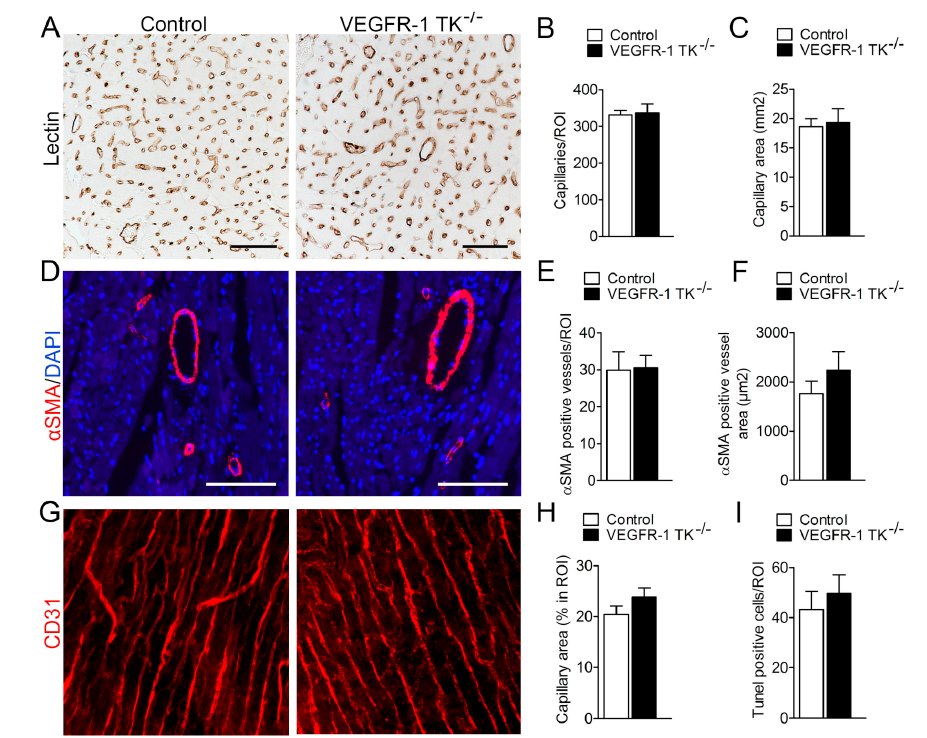
Figure 5. VEGFR-1 TK signaling does not affect angiogenesis. ( A ) Representative images of lectin staining of myocardial sections at day 14 of angII infusion (scale bar is 50 µ m). ( B ) Quantification of capillary density in LV (n = 7–9/group). ( C ) Quantification of capillary area (n = 7–9/group). ( D ) Representative images of staining for arteries ( α SMA; scale bar is 100 µ m). ( E ) Quantifica- tion of arterial vessel density (n = 8–10/group). ( F ) Quantification of α SMA-positive vessel area (n = 8–10/group). ( G ) Representative images of staining for CD31 to visualise capillary tree at base- line. ( H ) Quantification of capillary area (n = 6–9/group). ( I ) Quantification of apoptotic cells at day 14 of angII infusion (n = 8–10/group). Values are mean ± SEM. Statistical analyses were performed using Students t -test. *** p < 0.001; ** p < 0.01; * p <